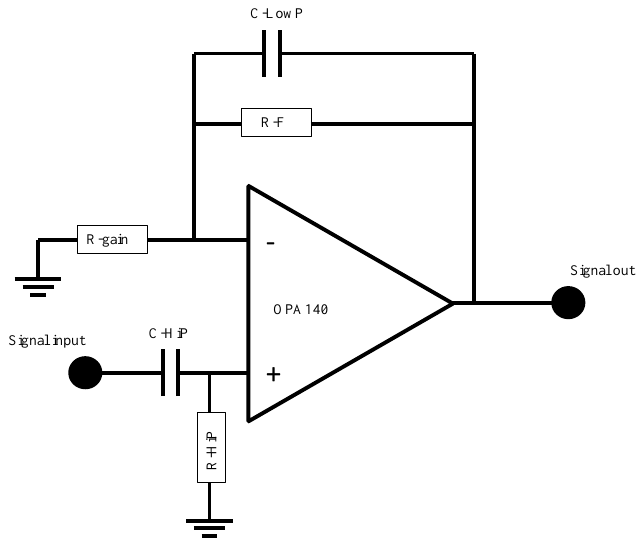
Figure 2. Simplified schematic limited to limbs’ connections and one of the precordials.